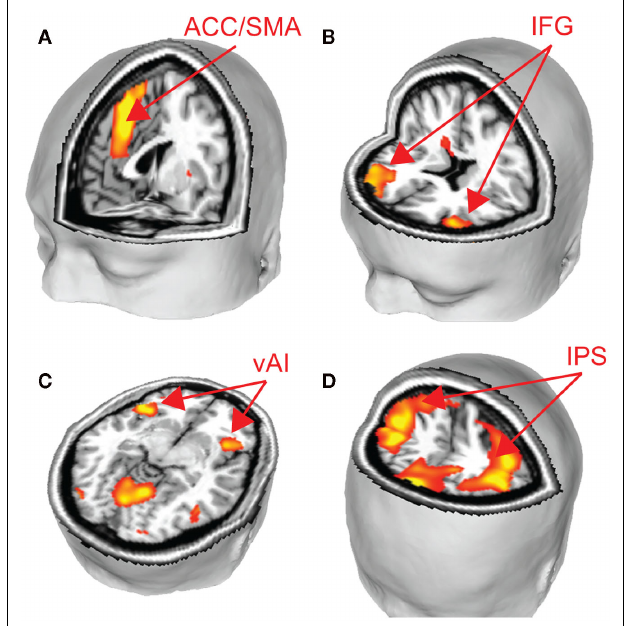
FIGURE 2 | Probability of choosing the safe option plotted against ratio. A median split was performed, with data from low social phobia (SPIN) individuals plotted in blue and high SPIN in red. Linear fits were determined across all trials with ratio modeled as a continuous variable. For illustration, choices were grouped into seven ratio bins (1, 1.25/1.3333, 1.5, 1.6667/1.75, 2, 2.3333/2.5, 3) and plotted against mean probability of choosing the safe option for high and low SPIN